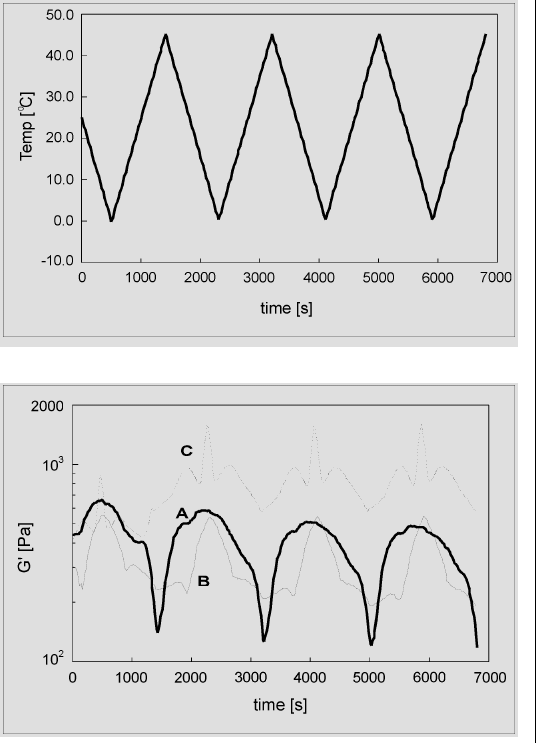
Figure 2 (left above): Temperature dependence of tan d (G”/G’) for A, B and C body lotions at 10 rad/s and 4°C/min from 0 to 60°C. Figure 3 (right above): Temperature profile for thermal circle test at 10 rad/s with heating rate 3°C/min. Figure 4 (left below): Data of G” versus tempera- ture of thermal circle test for A, B and C body lotions. Figure 5 (right below): G’ versus time of thermal circle